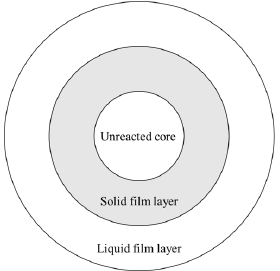
Figure 9. Schematic diagram of the unreacted shrinking core